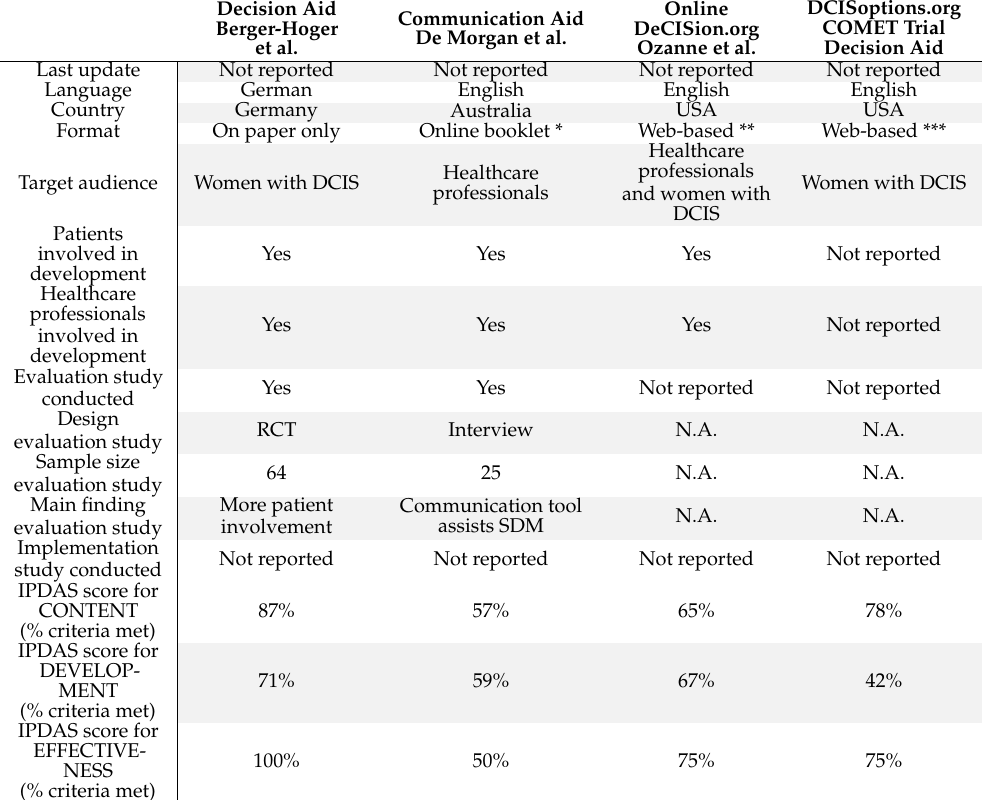
Table 1. Overview of patient decision aids on treatment decision for (low-risk)